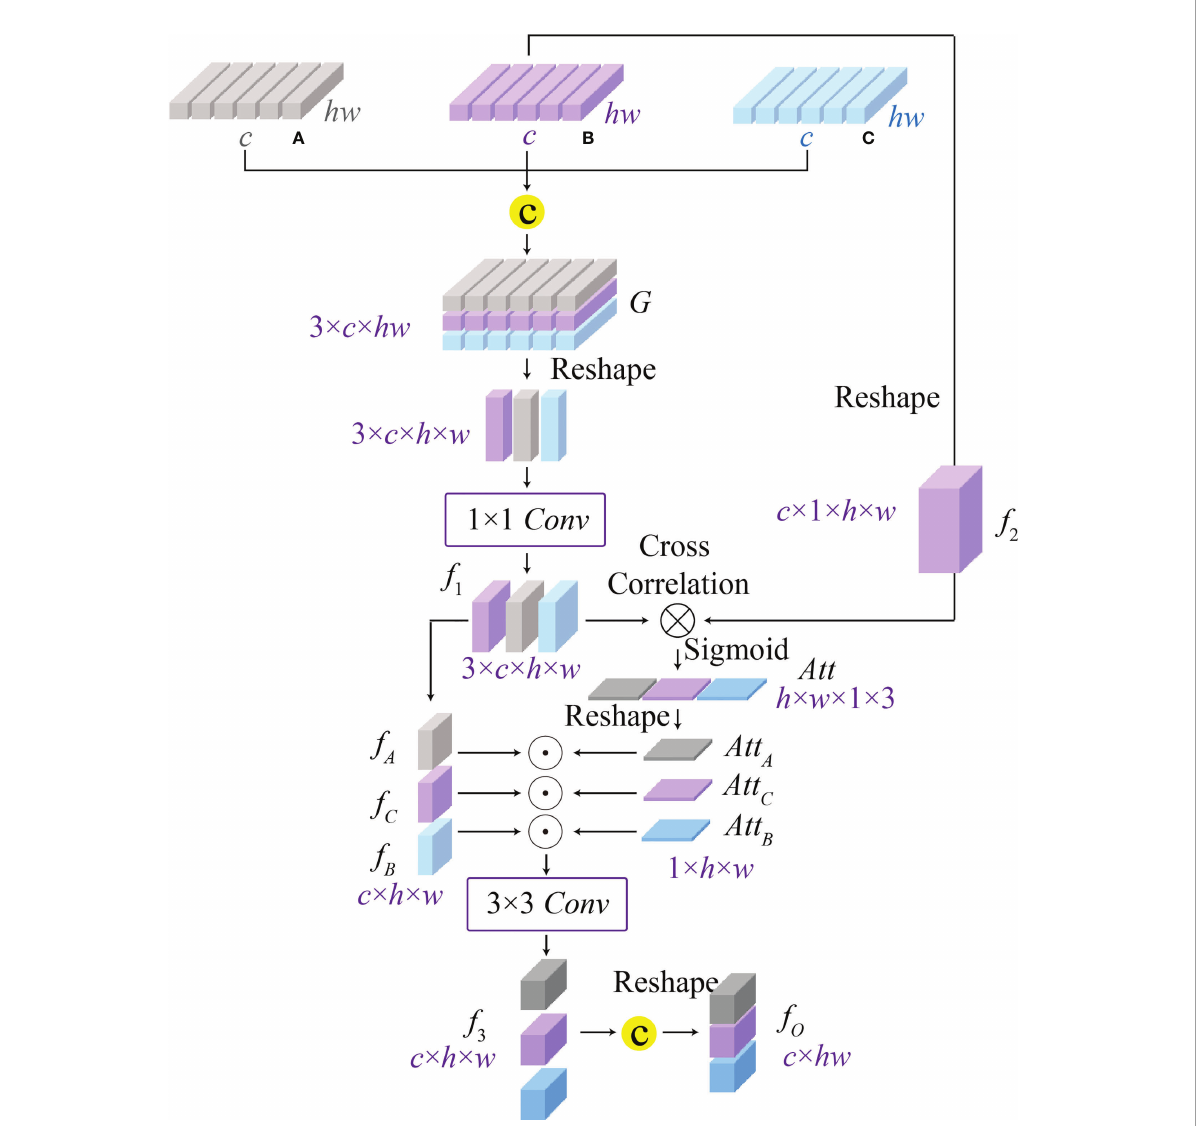
FIGURE 5 The architecture of the proposed cross-correlation attention module (CAM), which can model the spatial-level relationship between multi-scale features (A – C) from the global-guided, the local-guided, and the feature aggregation branches for achieving the multi-scale feature